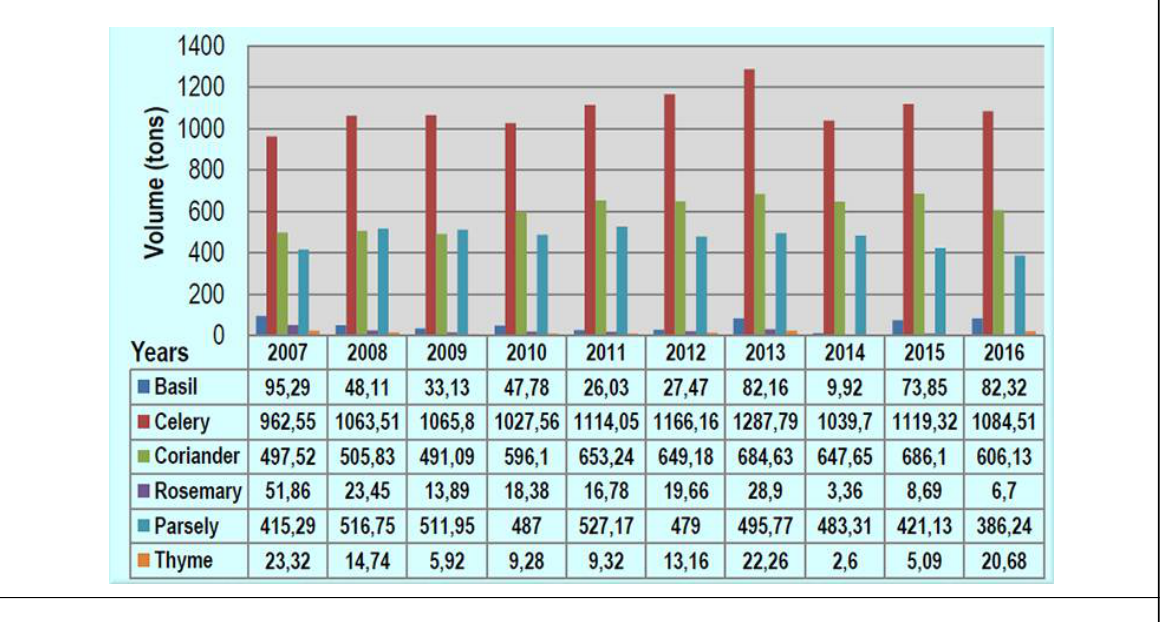
Figure 3: Sales volumes of herbs sold at national fresh produce markets in South Africa Source: Statistics and Economics Analysis, DAFF; Retrieved from